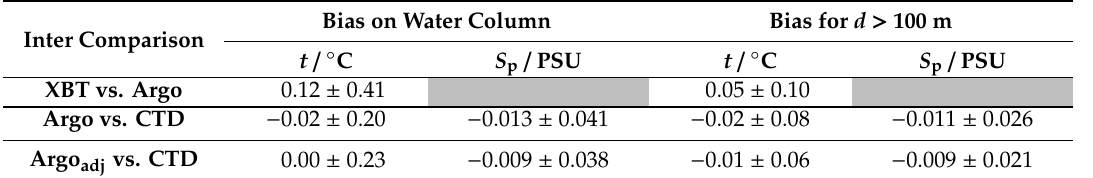
Table 9. Final assessment of biases (with associated